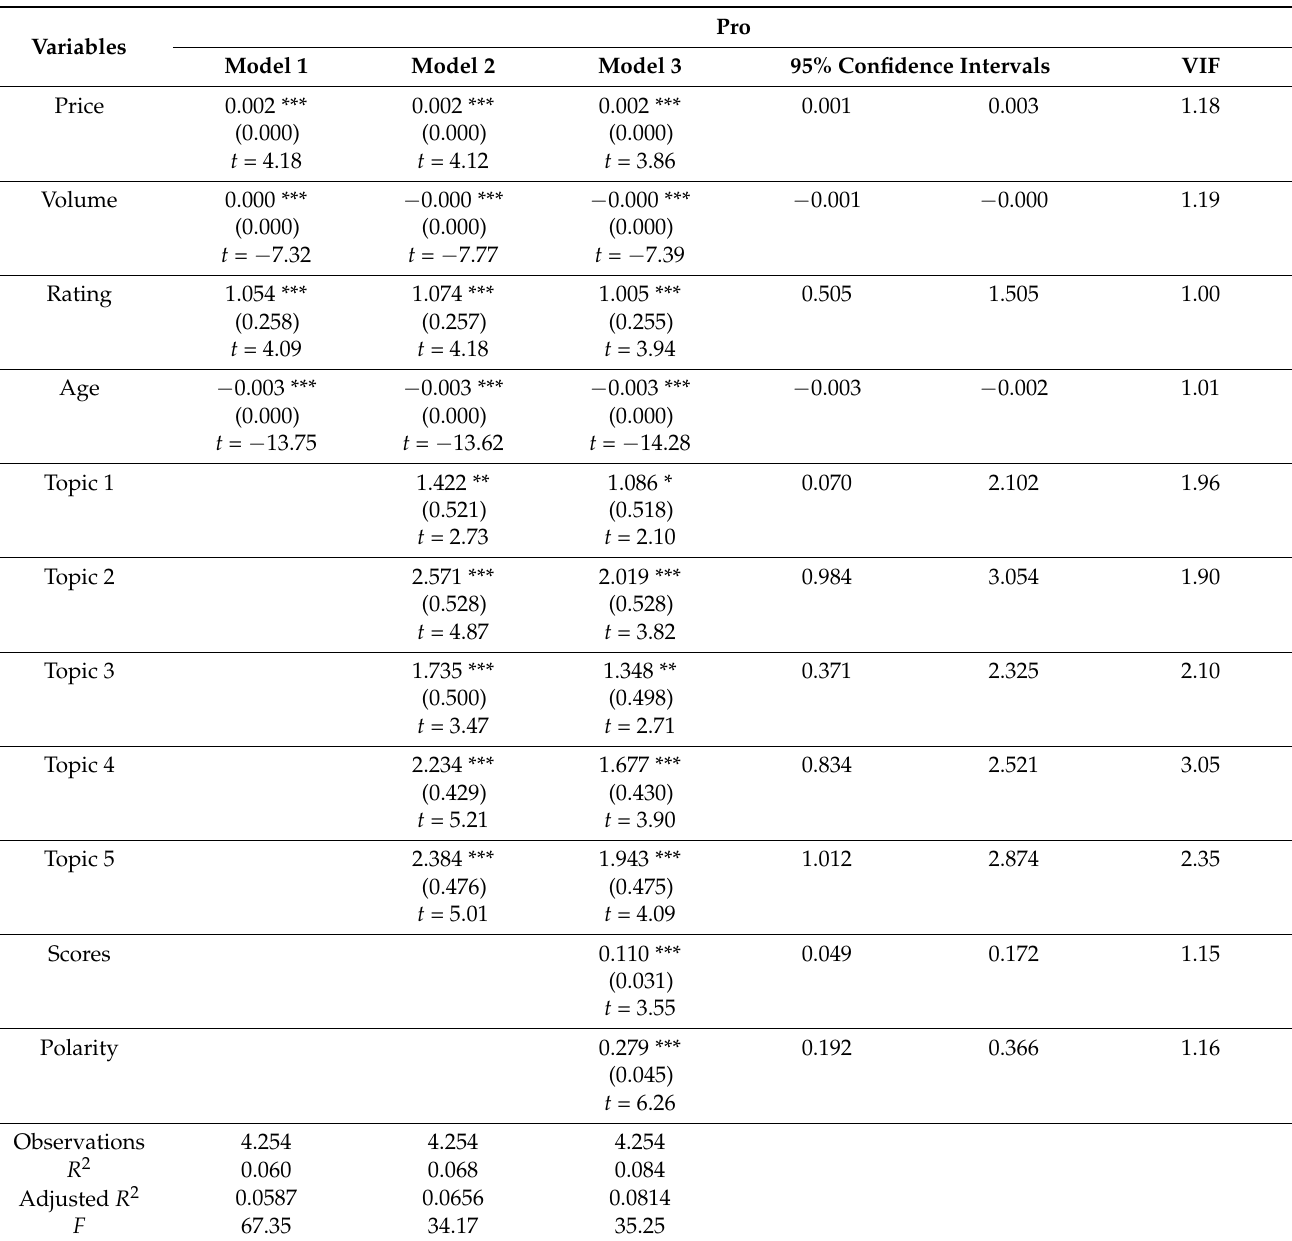
Table 5. Regression analysis